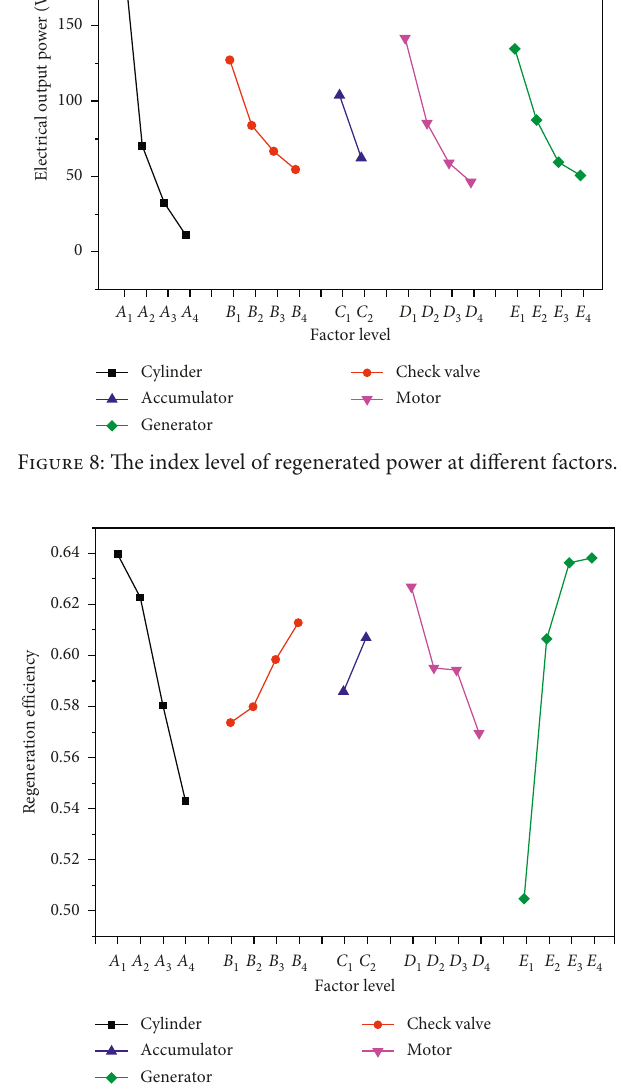
Figure 7: The index level of motor pressure at different factors.